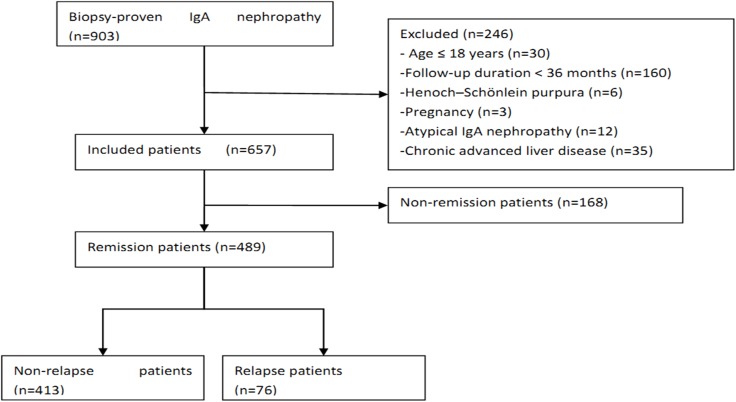
A flow diagram of the study.